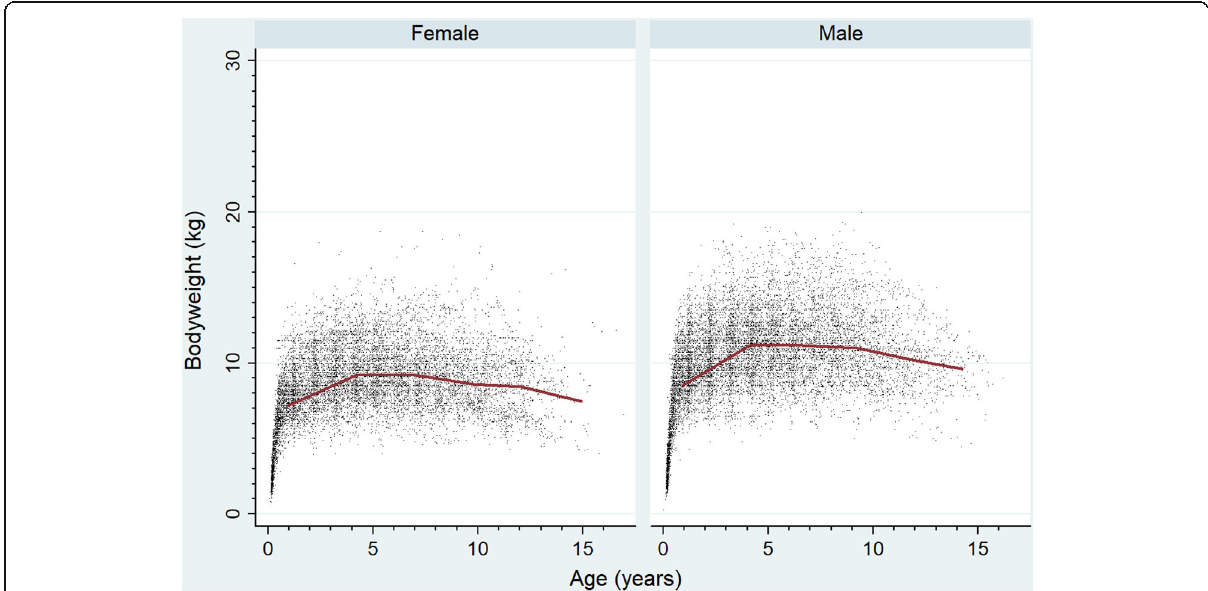
Fig. 2 Bodyweight growth curves overlaid with a cross medians line plot for female and male Miniature Schnauzers attending UK primary-care veterinary clinics participating in the VetCompass ™ Programme. (12,443 bodyweight values from 1284 females and 12,545 bodyweight values from 1327